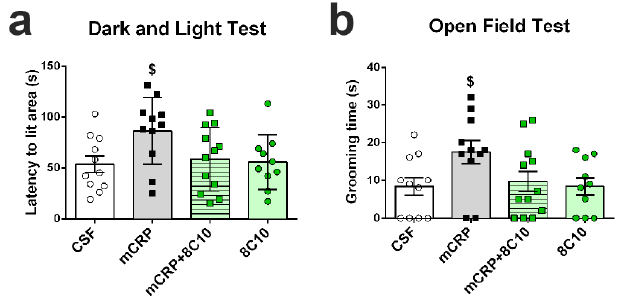
Figure 2. Anxiety induced by mCRP treatment was not evident in the co-treatment with 8C10 antibody. Six months of exposure to mCRP induced traits of anxiety, as shown by increased latency to enter to the lit area in the dark and light test ( a ) and increased grooming time in the open-field test ( b ). 8C10 showed a clear trend toward protecting against anxiety. Values are mean ± SEM (CSF N = 11, mCRP N = 11, mCRP + 8C10 N = 12 and 8C10 N = 10). Statistics: one-way ANOVA showed a trend to significance ( a ) p = 0.068, ( b ) p = 0.058; $ p < 0.05 compared to control by Student’s t